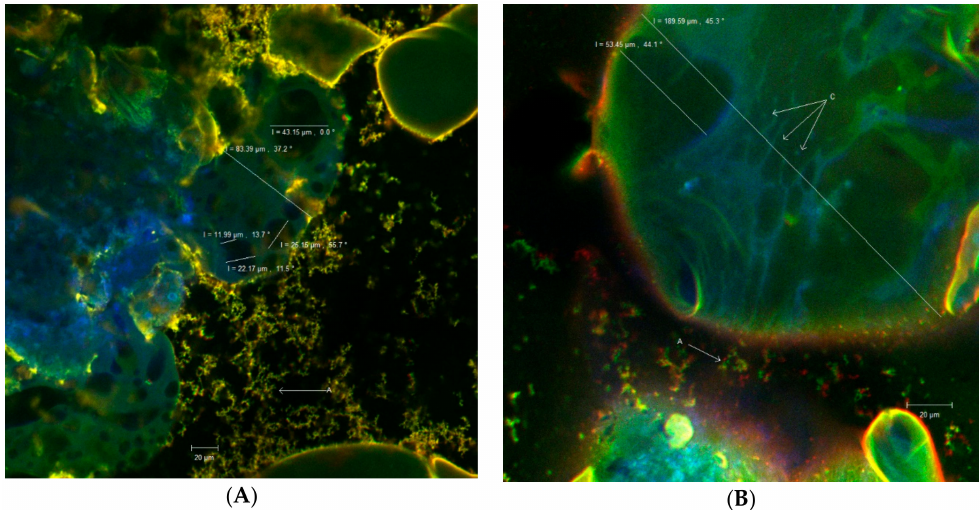
Figure 1. ( A , B ) Confocal microscopy images highlighting the double coacervation of anthocyanins from sweet cherries skins: A—Aggregates, C—Coacervates (The images taken over by the ZEN Black 2012